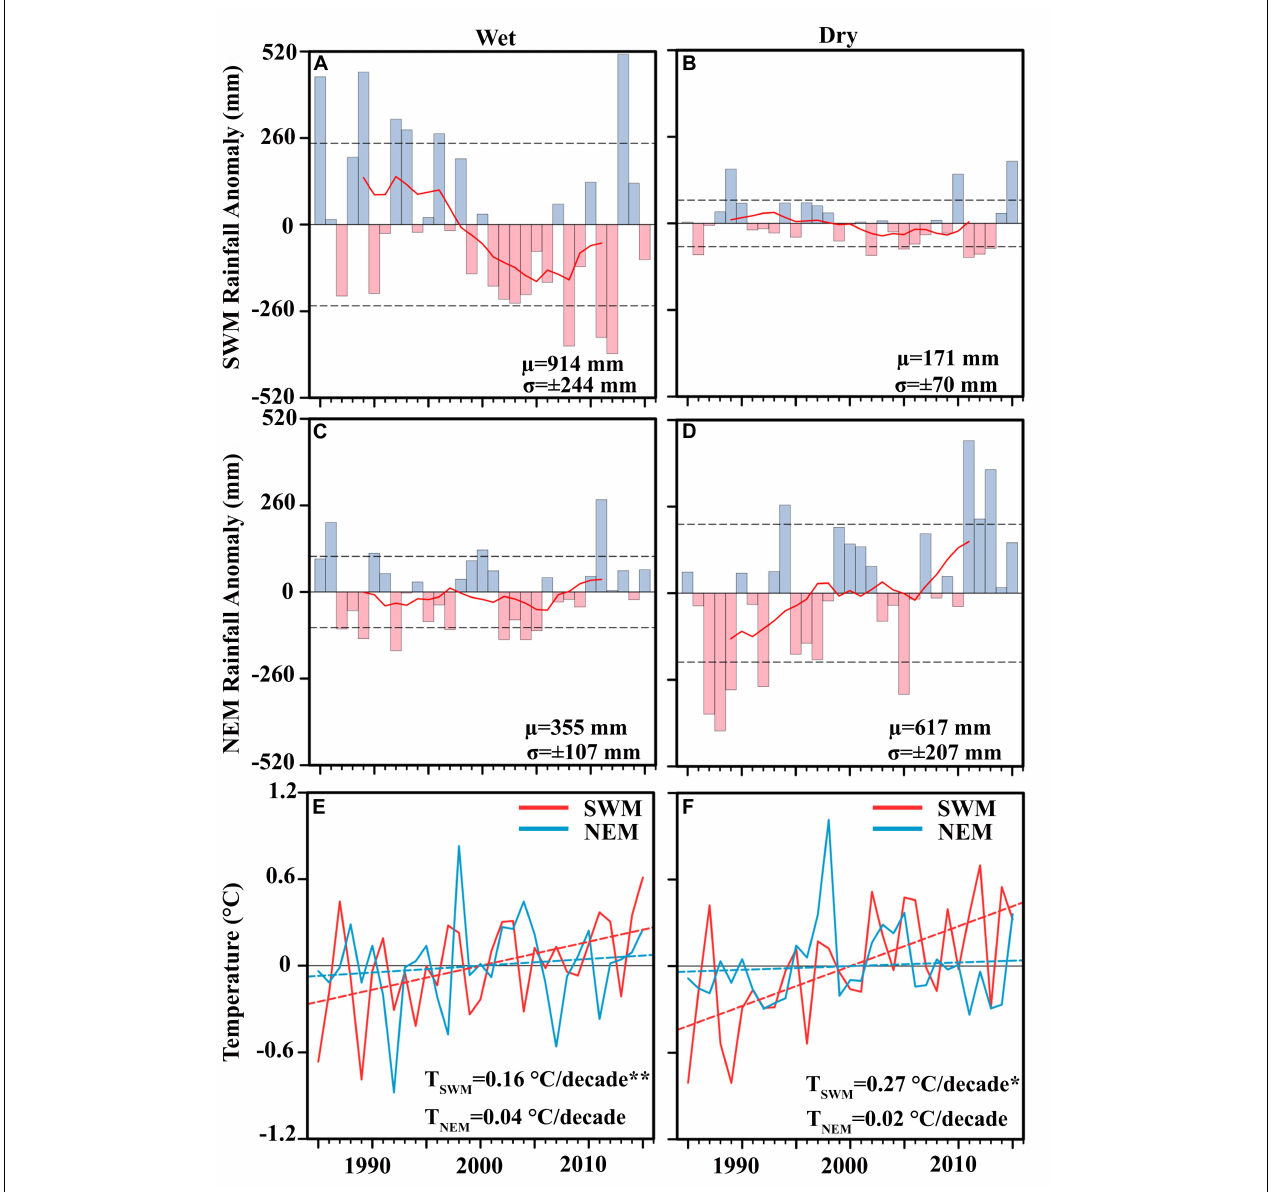
FIGURE 8 | Temporal evolution of total rainfall anomalies (Unit: mm) during the southwest monsoon (SWM) season for (A) wet, and (B) dry regions in Mahaweli River Basin from the 1985 to 2015 period, the middle panel is same as a top panel but for the northeast monsoon (NEM) season for (C) wet, and (D) dry regions, and the red line indicates a 9-year running mean. The temperature anomaly in SWM and NEM seasons in the wet and dry region and their trends (T SWM , T NEM ) are depicted in (E,F) , respectively. **and *marks represent the statistically significant trend at 95 and 99% confidence level. The µ and σ represent the long-term mean and standard deviation of rainfall and